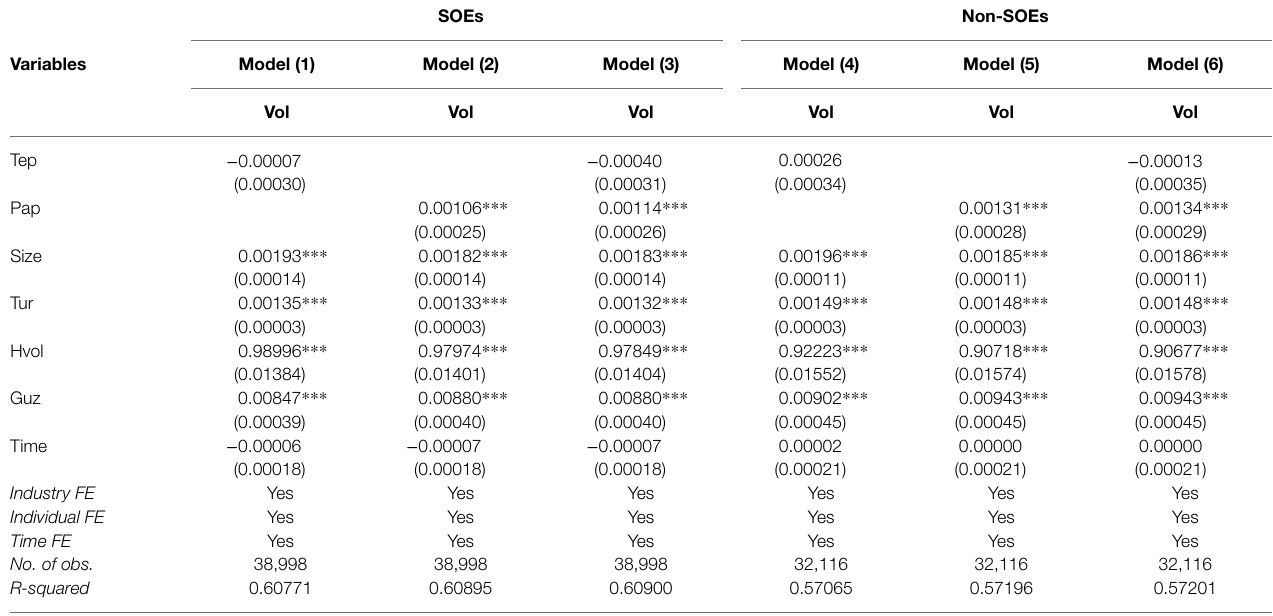
TABLE 6 | Heterogeneity results for state